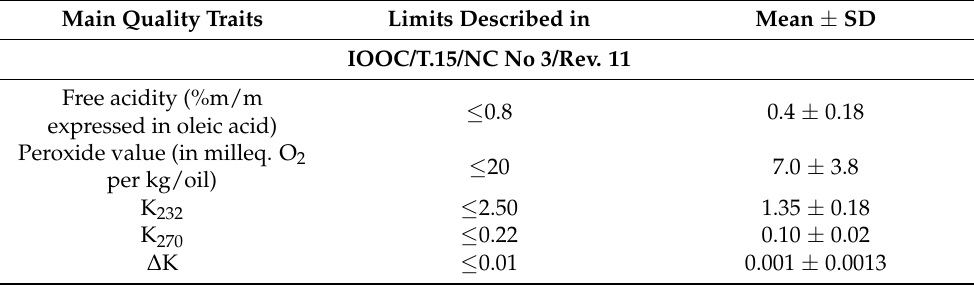
Table 1. Main olive oil quality traits. Average and standard deviation (SD) of all olive oil samples (n = 24). Limits for classification of extra-virgin olive oil by the International Olive Council. Main Quality Traits Limits Described in Mean ± SD IOOC/T.15/NC No 3/Rev.